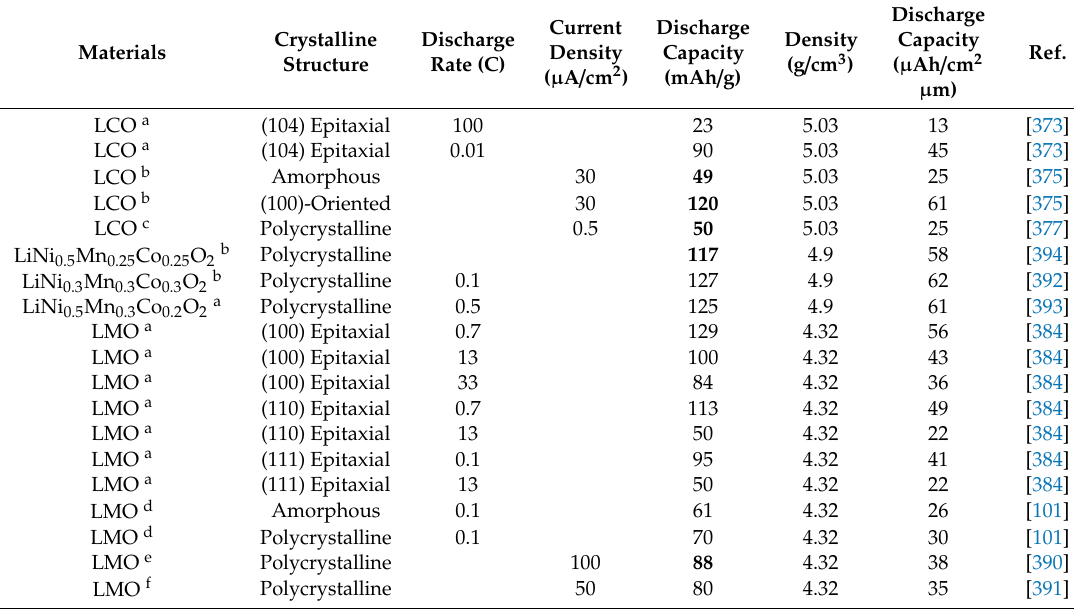
Table 7. Comparison of the discharge capacity among di ff erent cathode